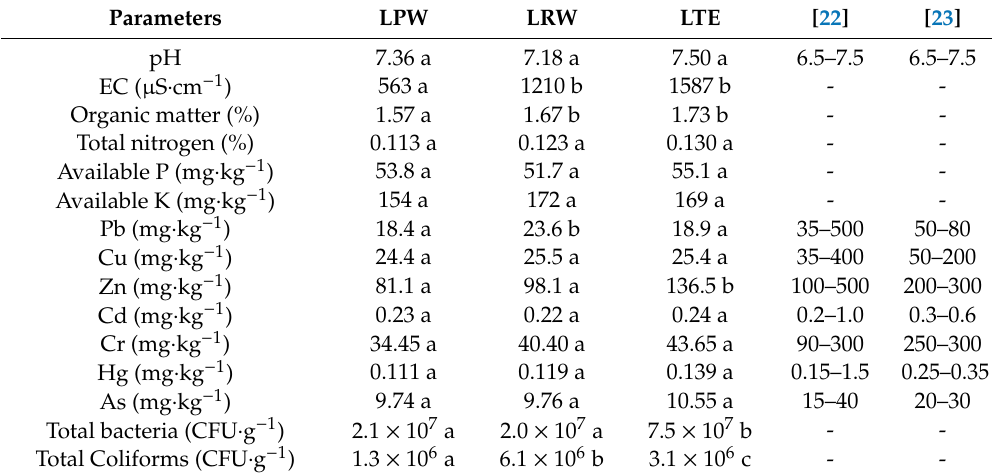
Table 2. Characteristics of the irrigated soils as compared with the guidelines for soil